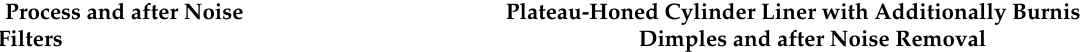
Table 3. Surface texture parameters calculated for plateau-honed cylinder liners (left) and with additionally burnished dimples (right part) before and after noise, including and reduction by different regular